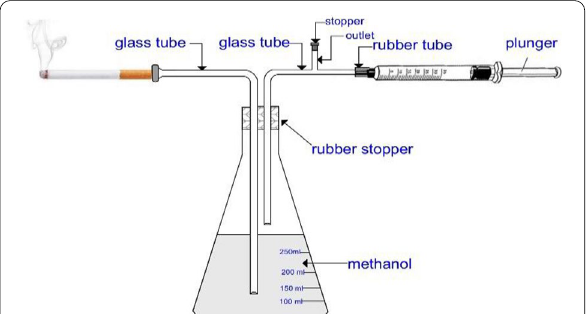
Fig. 3 Assembly of cigarette smoking